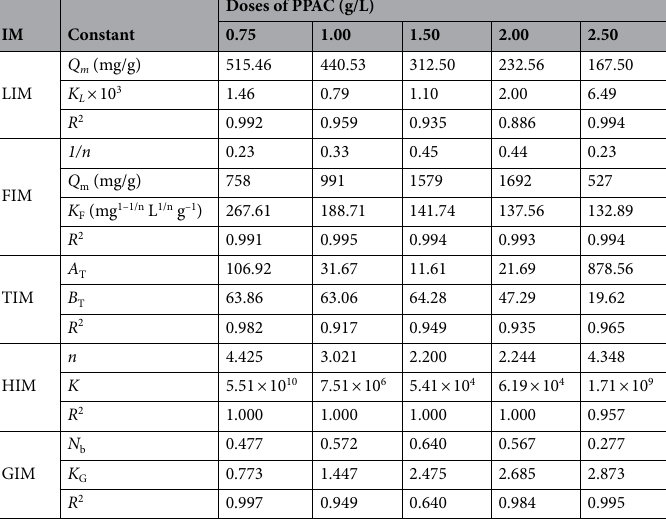
Table 2. IM investigation data of AY11 dye removal by PPAC adsorbent (AY11 (100–400 mg/L), PPAC doses (0.75–2.50 g/L), Temp. (at 25 ± 2